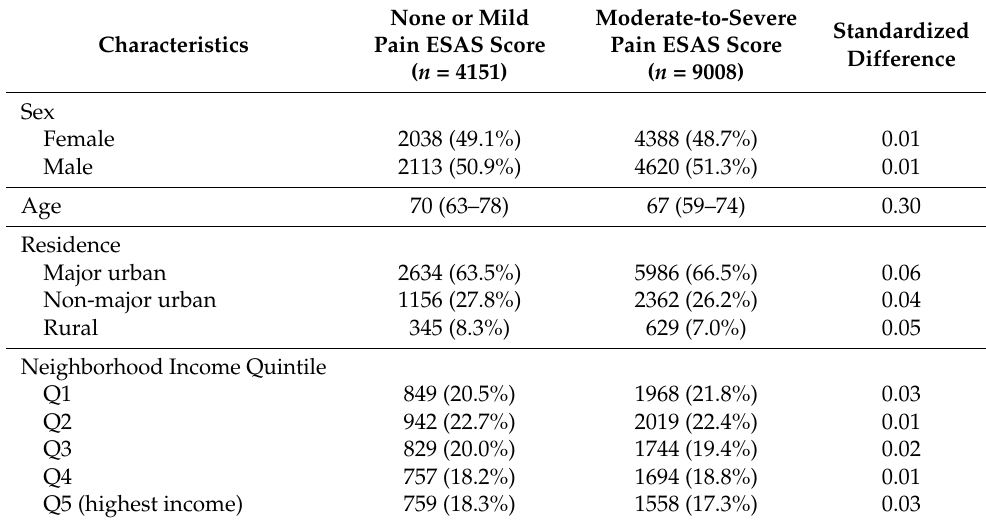
Table 1. Baseline characteristics for patients with and without moderate-to-severe pain ESAS